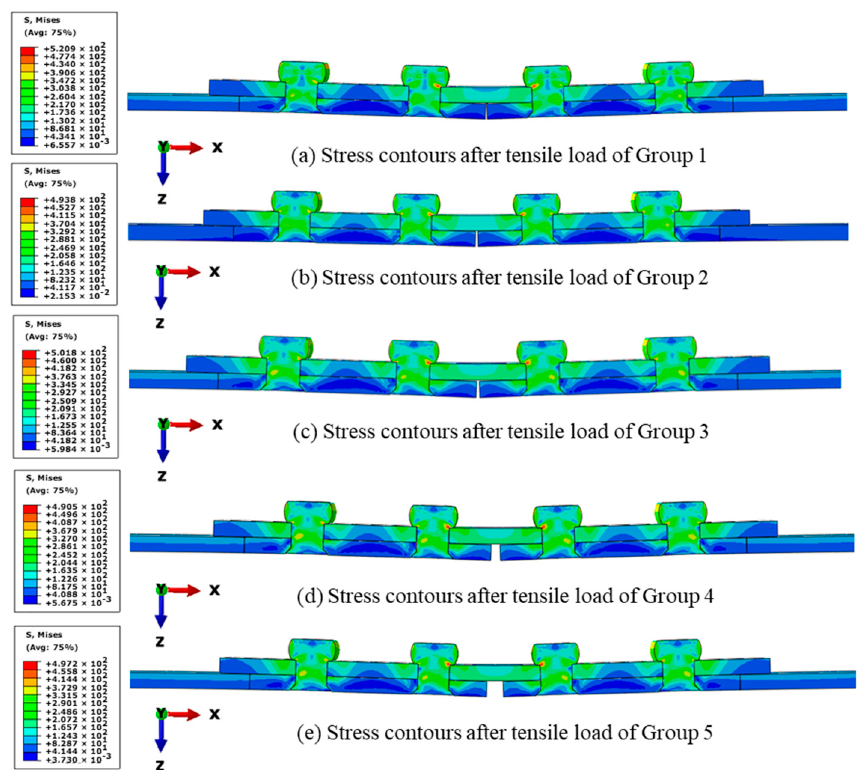
Figure 15. Stress contours of the riveted single-strap butt joints after tensile load (Unit: MPa). ( a ) Stress contours of Group 1. ( b ) Stress contours of Group 2. ( c ) Stress contours of Group 3. ( d ) Stress contours of Group 4. ( e ) Stress contours of Group 5.